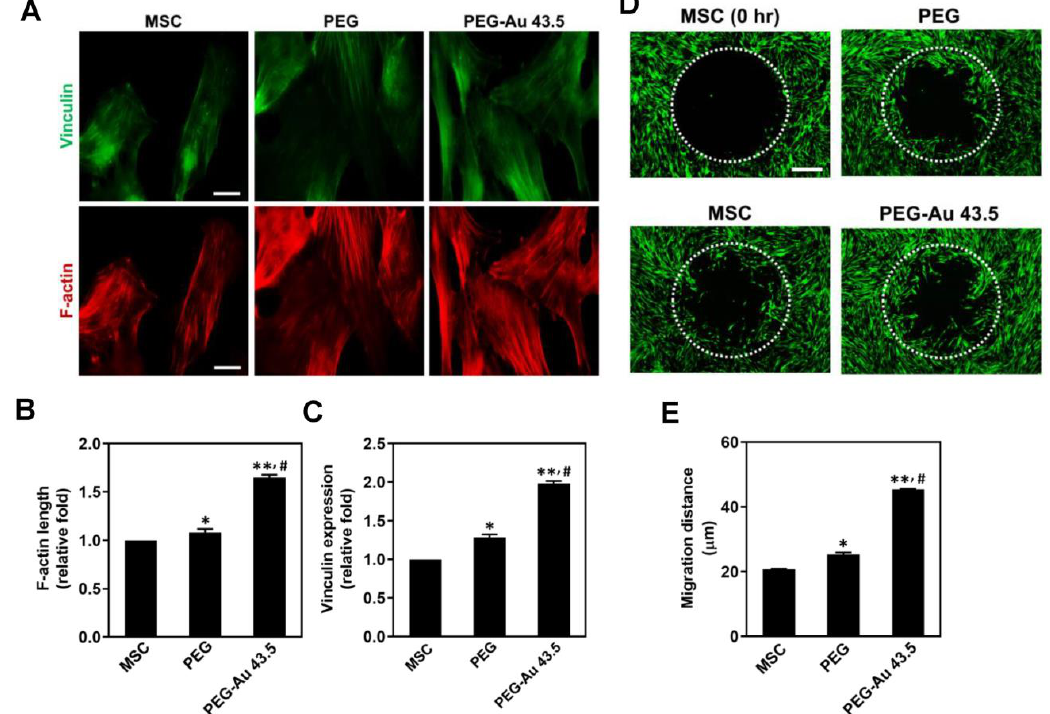
Figure 4. Evaluation of F-actin/vinculin expression and cell migration ability for MSCs incubating with pure PEG and PEG–Au 43.5 ppm at 24 h. ( A ) Firstly, F-actin (red color) was stained using Alexa phalloidin, while vinculin was immunostained using primary anti-vinculin antibodies conjugated with secondary FITC–immunoglobulin antibodies (green color). Cell nuclei were detected by DAPI solution (blue color). Scale bar = 20 μm. The ( B ) length of F-actin and ( C ) expression of vinculin were semi-quantified based upon fluorescence intensity. The results are represented as three independent experiments. Data are presented as mean ± SD. ( D ) The migration ability of MSCs was investigated at 24 h. MSCs migrating into the gap zone area was observed by fluorescence microscopy. The cells were stained by calcein –AM (2 μM) before observation. Scale bar = 200 μm. ( E ) The semi-quantitative results for the migration distance of MSCs at 24 h. Data are represented as mean ± SD (n = 3). * p < 0.05, ** p < 0.01: compared to the MSC alone group. # p < 0.05: compared to the pure PEG group.